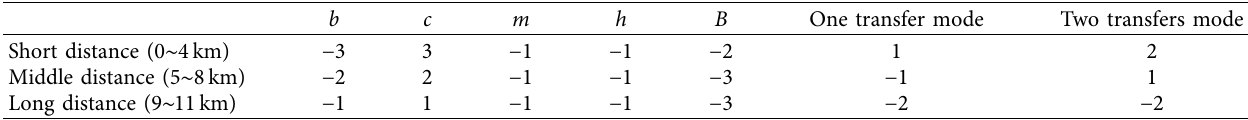
Figure 16: Mode fow of original network. (a) Single-mode fow. (b) One transfer mode fow. (c) Two transfers mode fow. Table 8: Te modal shift weight